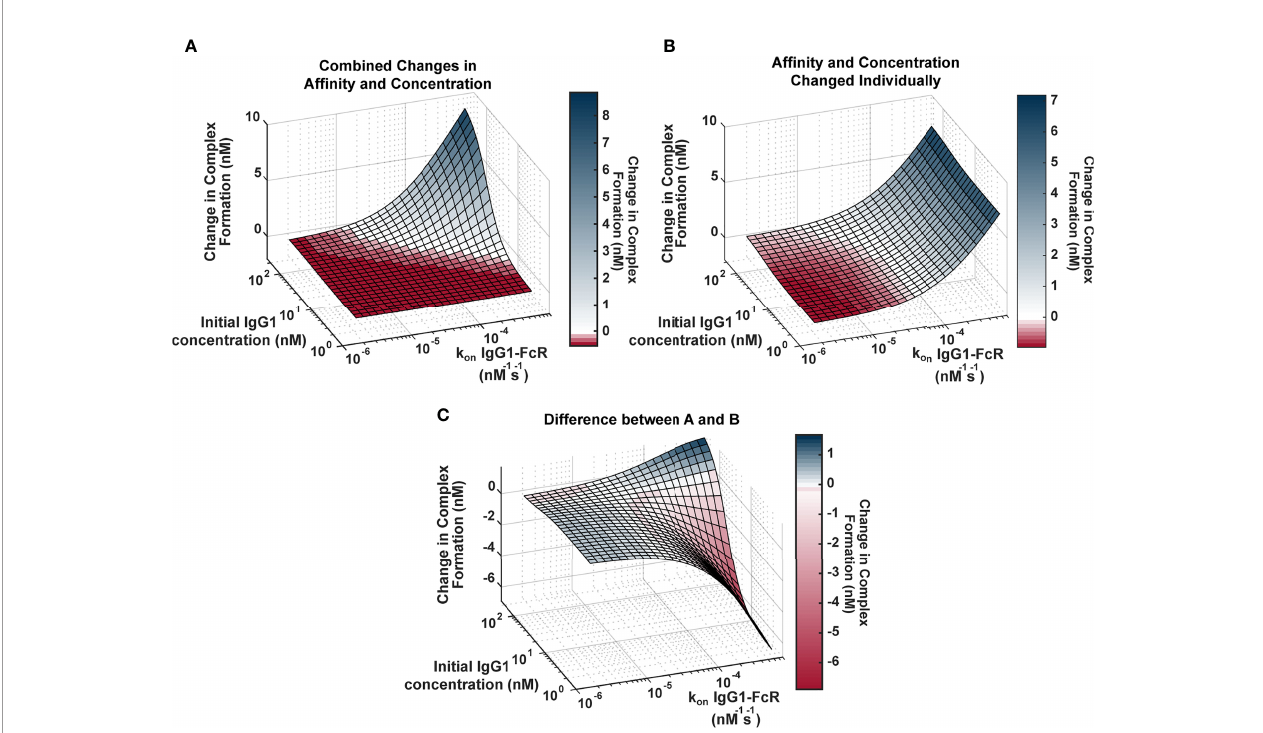
FIGURE 2 | Landscape illustrating the relationships between IgG1 concentration and IgG1- Fc g R af fi nity across the physiological landscape of parameters (2500 unique parameter combinations). (A) Model predictions for the change in complex formation from baseline when IgG1 initial concentration (x axis) and k on IgG1- Fc g R (y axis) were altered individually and the resulting change in complex formation is added together (z axis). Color indicates predicted change in complex formation from baseline. (B) Model predictions for the change in complex formation from baseline when both parameters are altered simultaneously in the model. Color indicates predicted change in complex formation from baseline. (C) The difference between (A, B) , illustrating parameter combinations where synergy occurs. Blue indicates positive synergy, where the combined parameter changes (B) result in greater complex formation compared to was predicted by separate changes added together (A) , white indicates no synergy, and red indicates anergy; where the combined parameter changes (B) result in lower complex formation compared to was predicted by separate changes added together (A)